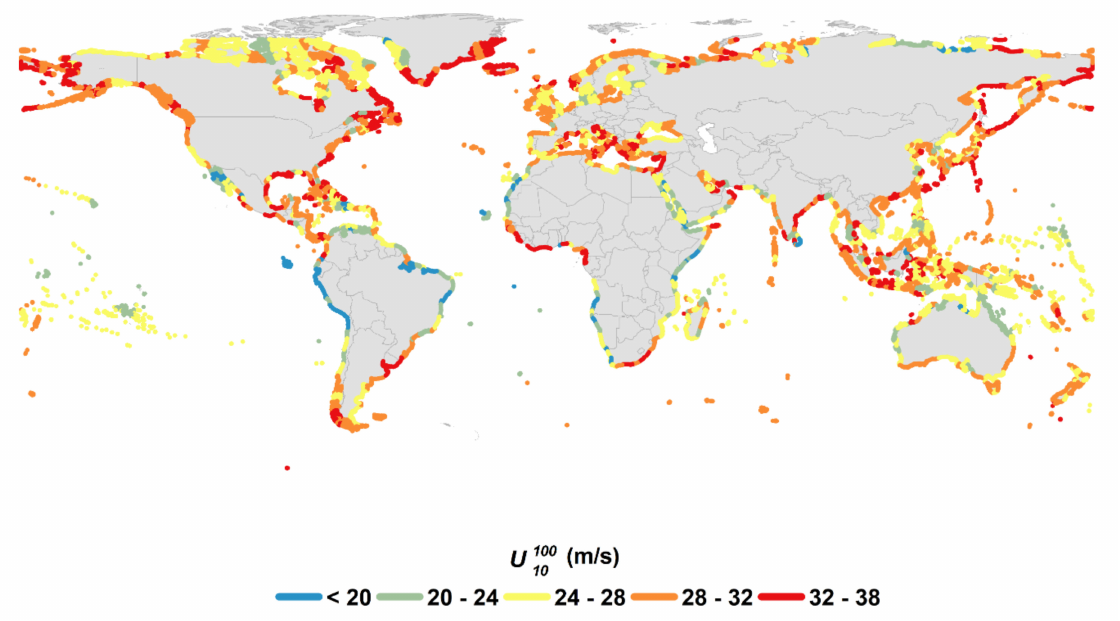
Figure 7. The 100-year return period wind speed, U 100 analysis and a GPD